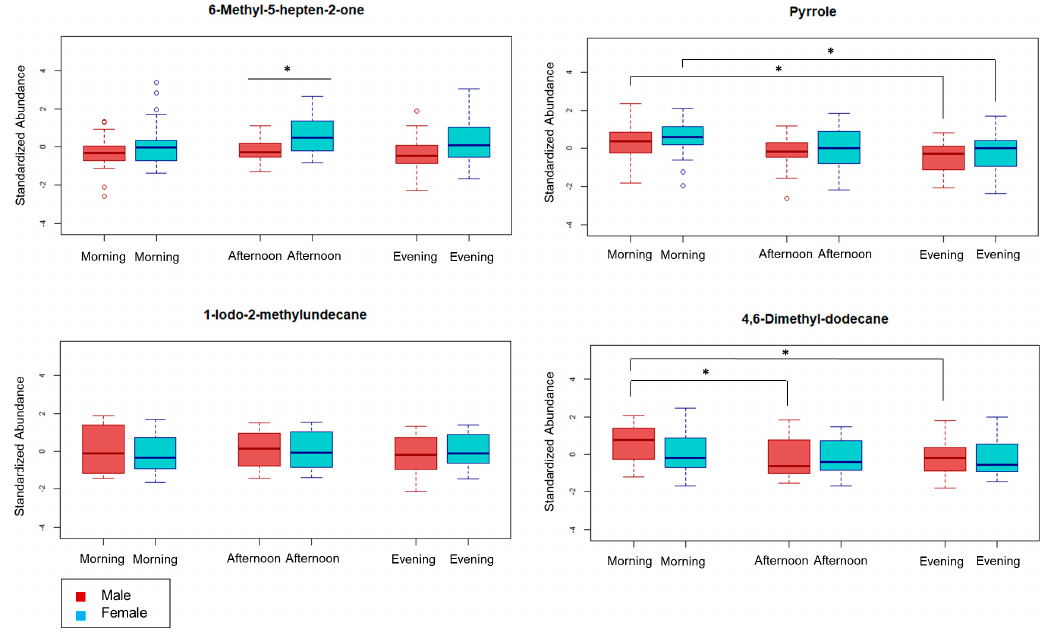
Figure 3. Putatively identified metabolites are presented as boxplots by time of day. Unpaired t-tests were applied to identify statistical significance across all sample subgroups. Statistical significance after an FDR correction is denoted with *.